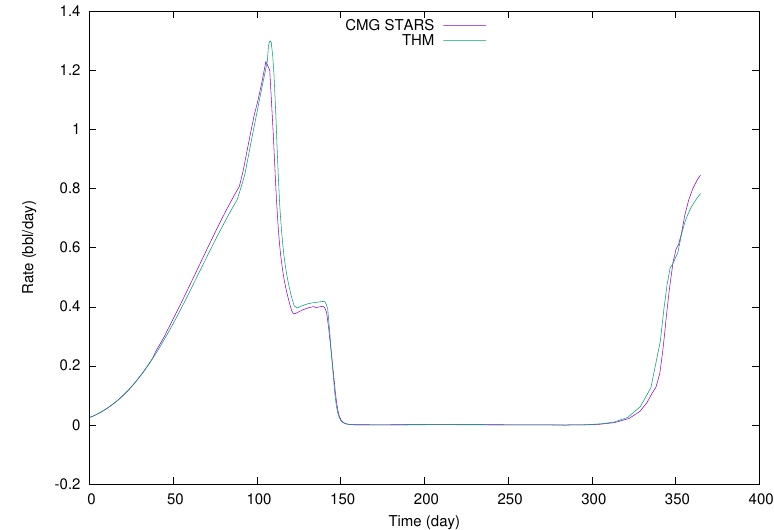
Figure 6. Example 1, oil production rate (bbl/day), first production well.